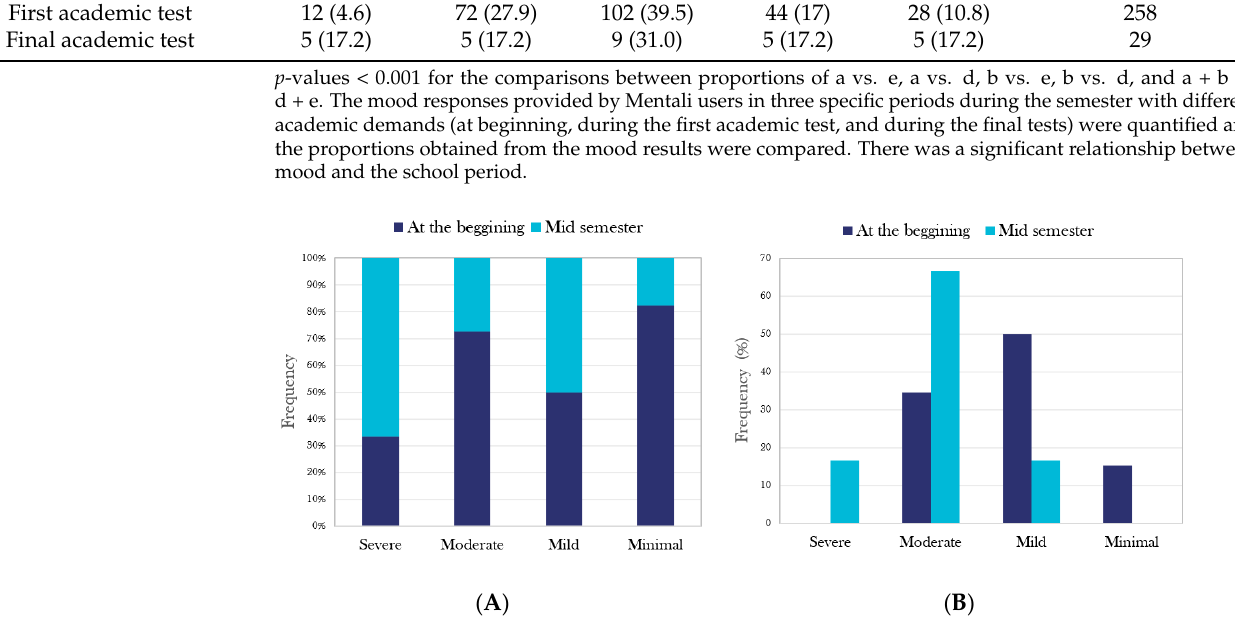
Figure 5. Evolution of the frequencies of anxiety and depression in medical students at two times during the school period. Considering the number of Beck inventories completed by the Mentali users at the beginning and at the middle of the semester, the proportions of positive screenings were considered to construct plots both for depression ( A ) and anxiety ( B ), stratified according to their severity.